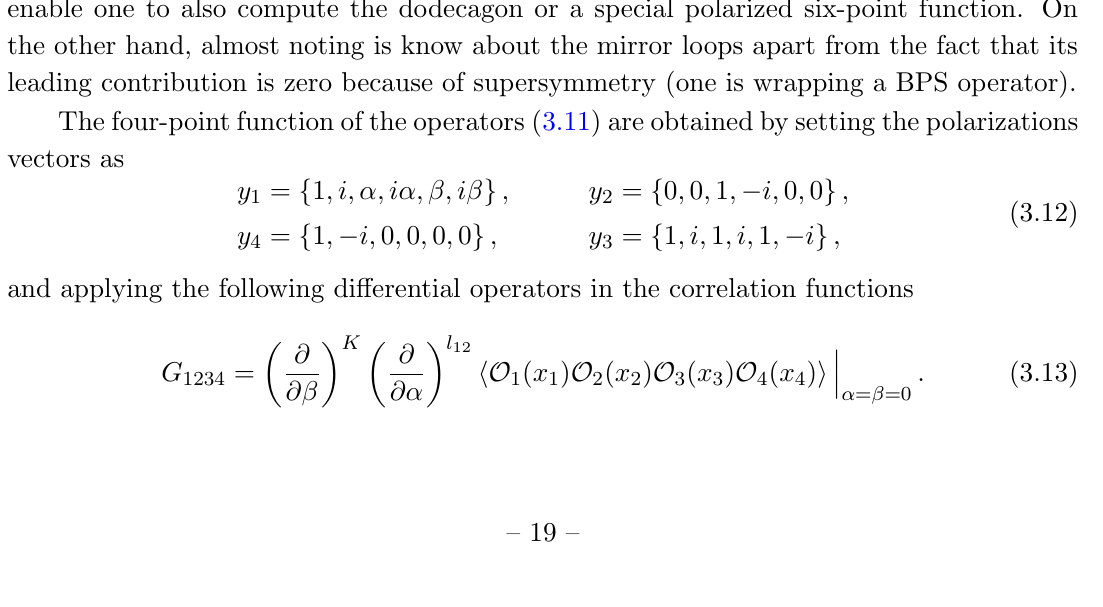
Figure 10 . An example of a tree-level contribution to the four-point functions computed using integrability. The other tree-level graphs are obtained by moving some of the lines connecting the operators and to the dashed line and there are K of them. For l 12 = 0 there are K O 1 O 3 additional graphs obtained by permuting and in the (cid:12)gure and moving the propagators. The O 1 O 4 bridge length l 12 will varry from case to case and the polarizations are such that y 24 = 0, see (3.12). As explained in the main text, using the two-particle integrability result computed in this paper we can evaluate l 12 < 3 up to two-loop and l 12 = l up to l loops. Notice that it is important to have non-zero connections between the operators and in order to suppress two new integrability O 1 O 3 contributions: three-particle in di(cid:11)erent edges and the loop over an operator which correspond to a four-particle